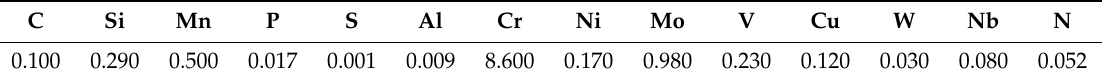
Table 1. Chemical composition of the parent metal SA 355 P91.